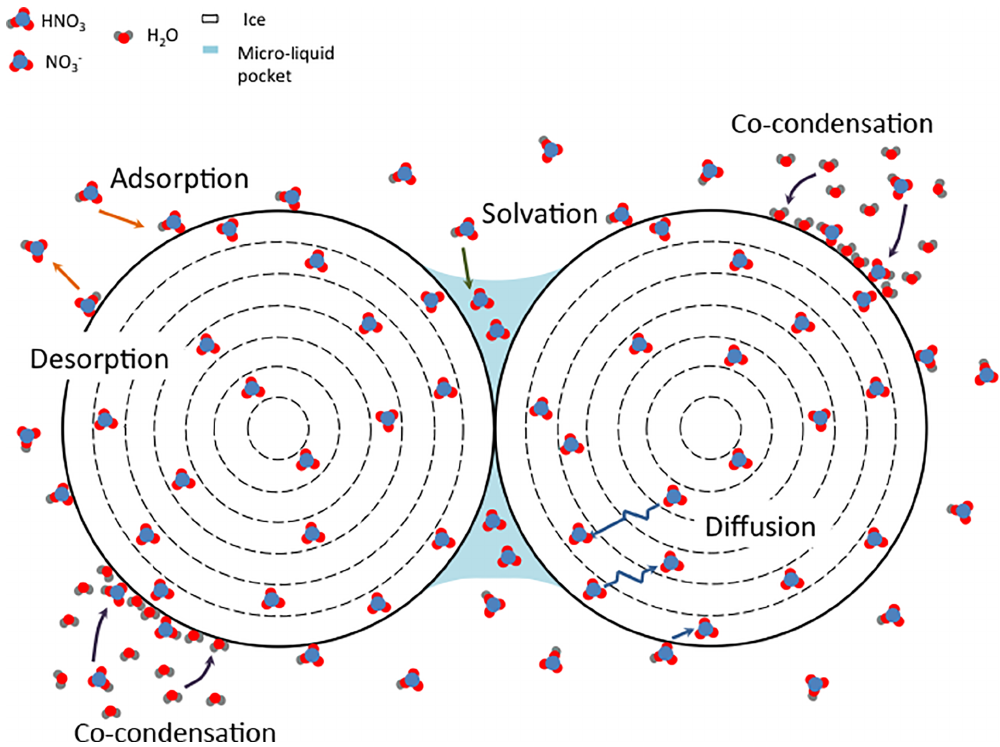
Figure 2. Schematic of Model 2. At T <T m , the concentration of NO − at the boundary of the snow grain is determined by air–ice processes, 3 i.e. non-equilibrium adsorption and co-condensation. At T ≥ T e , liquid is assumed to coexist with ice and the liquid fraction is in the form of micropockets that are located at grain boundaries and triple junctions (Domine et al.,